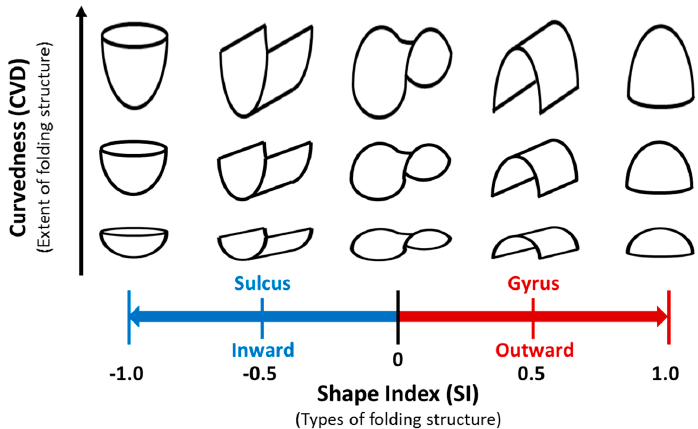
Figure 1. An illustrated diagram of the shape index (SI) and curvedness (CVD). The SI is a measure to describe the types of folding structures, with values ranged from − 1 (the inward or sulcal structure) to 1 (the outward or gyral structure); the CVD, on the other hand, measures the extent of a specific folding structure.